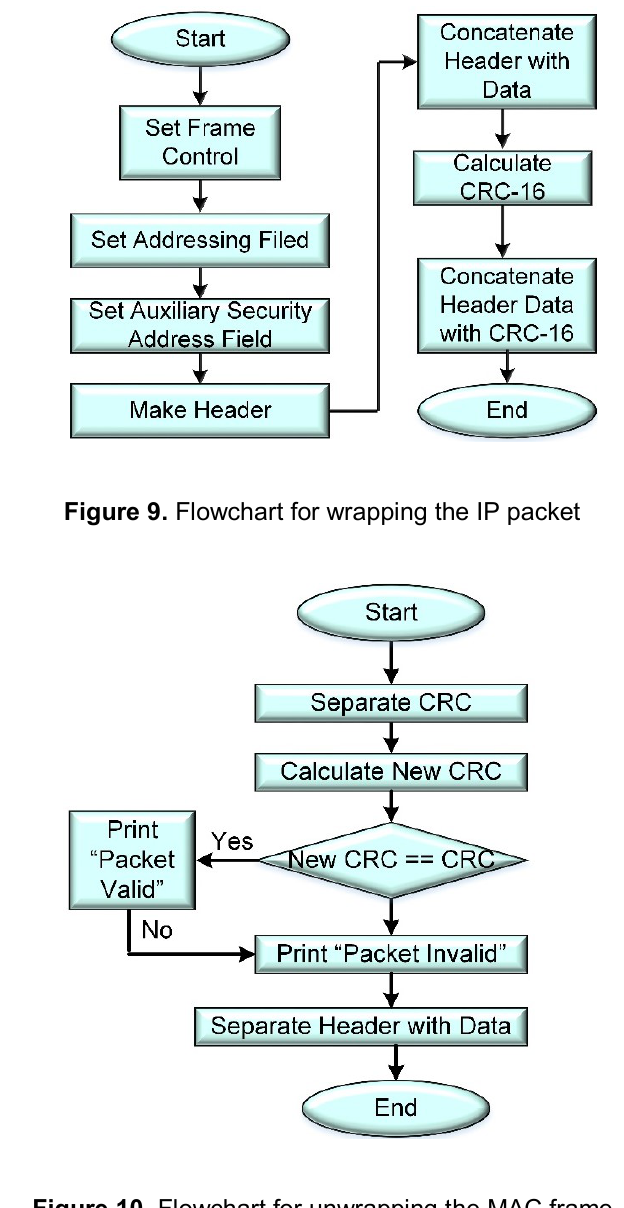
Figure 10. Flowchart for unwrapping the MAC frame and error detection using